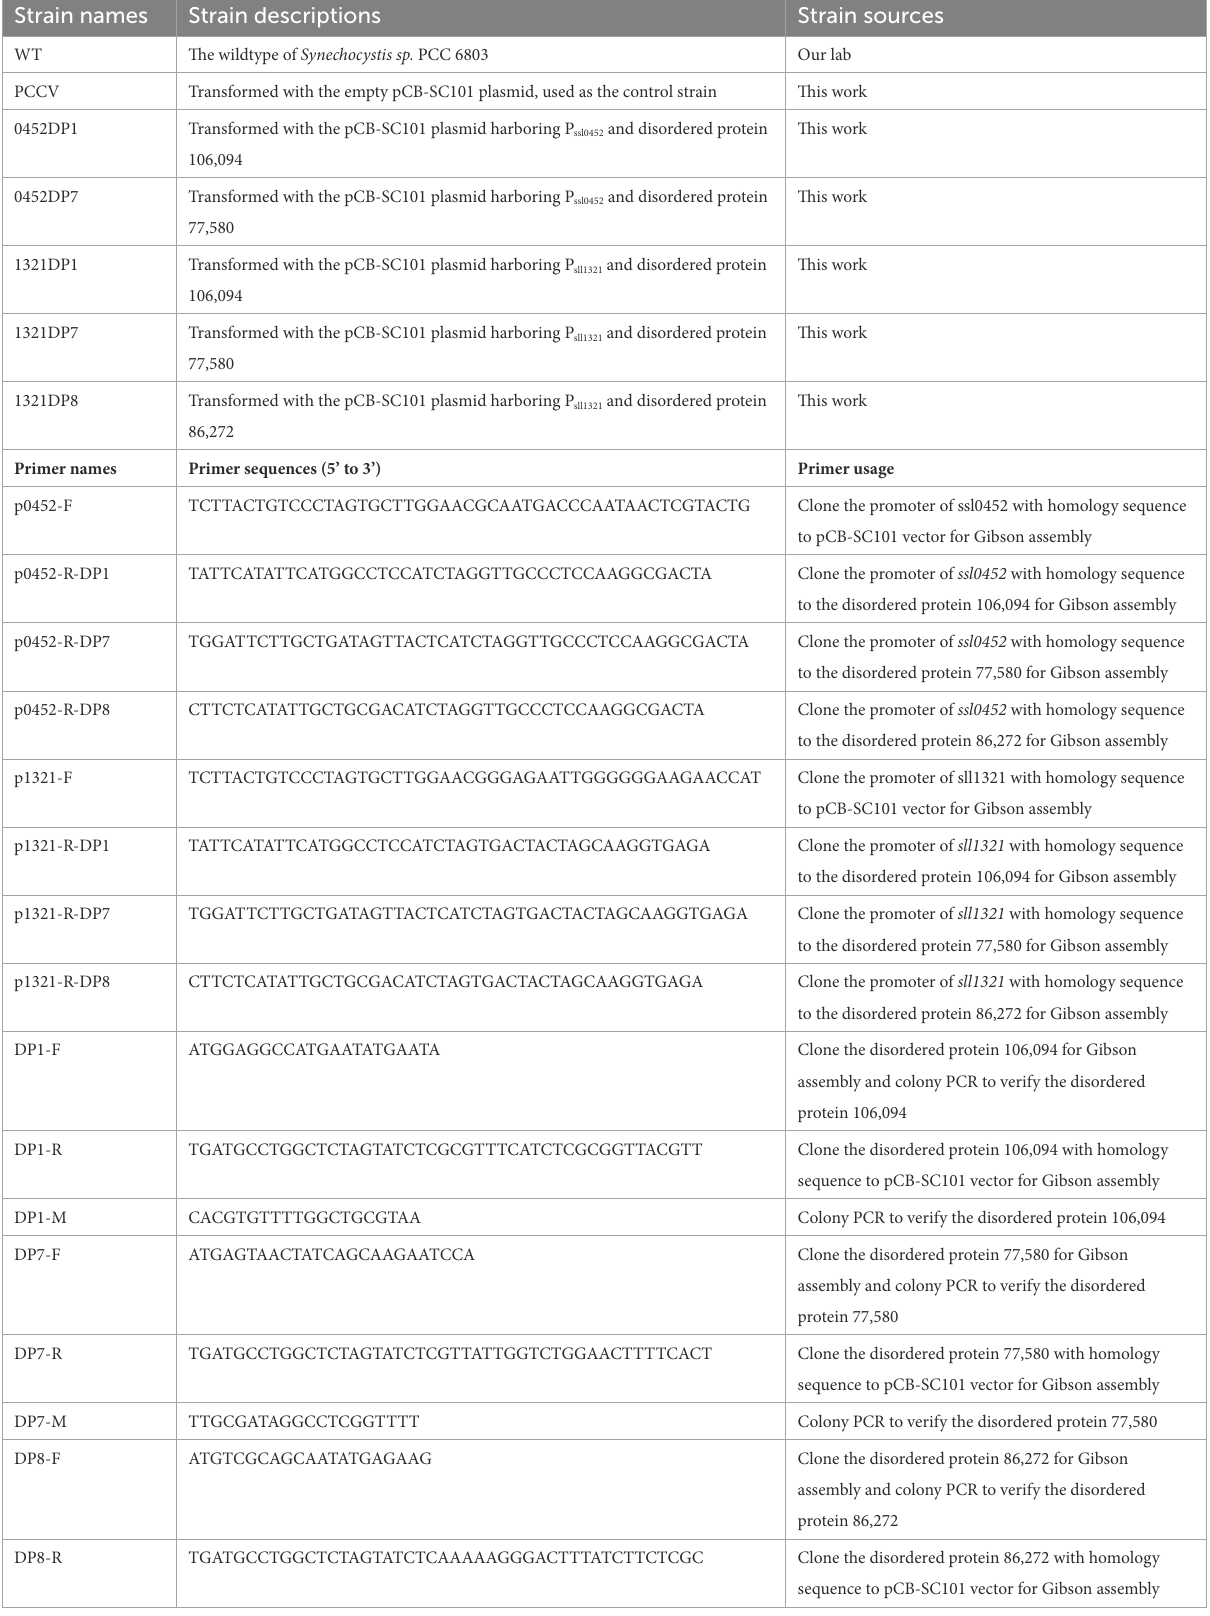
TABLE 1 Synechocystis strains and primers used in this